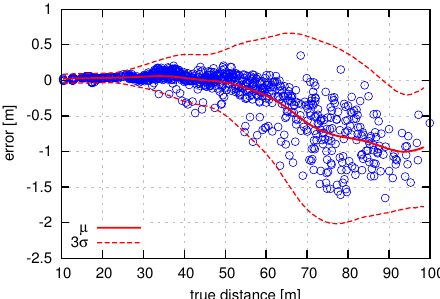
Figure 9: Error in distance measurement as a function of the true distance. We have also plotted a moving average and standard deviations computed with window size 10 m.